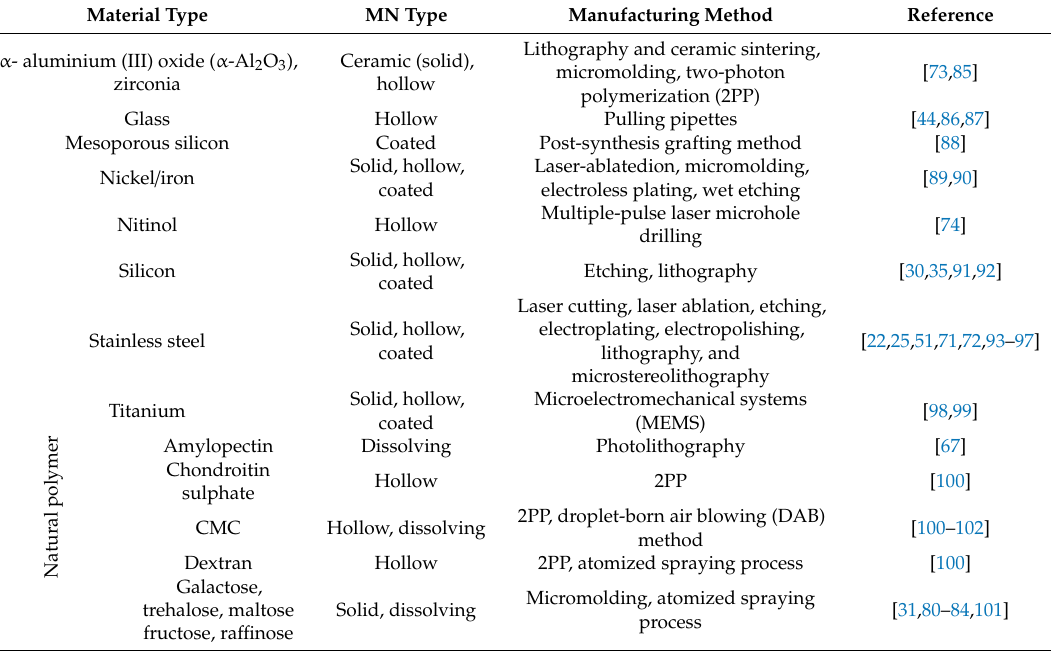
Table 1. Suitable materials for microneedle (MN)